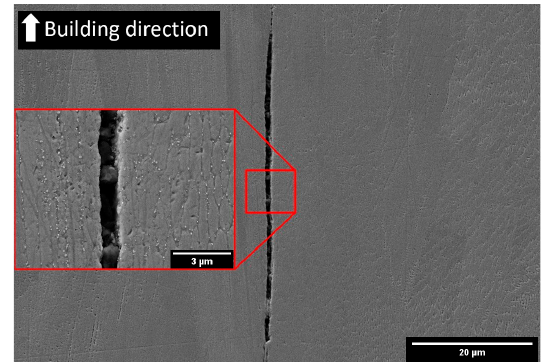
Figure 9. Grain boundary crack.